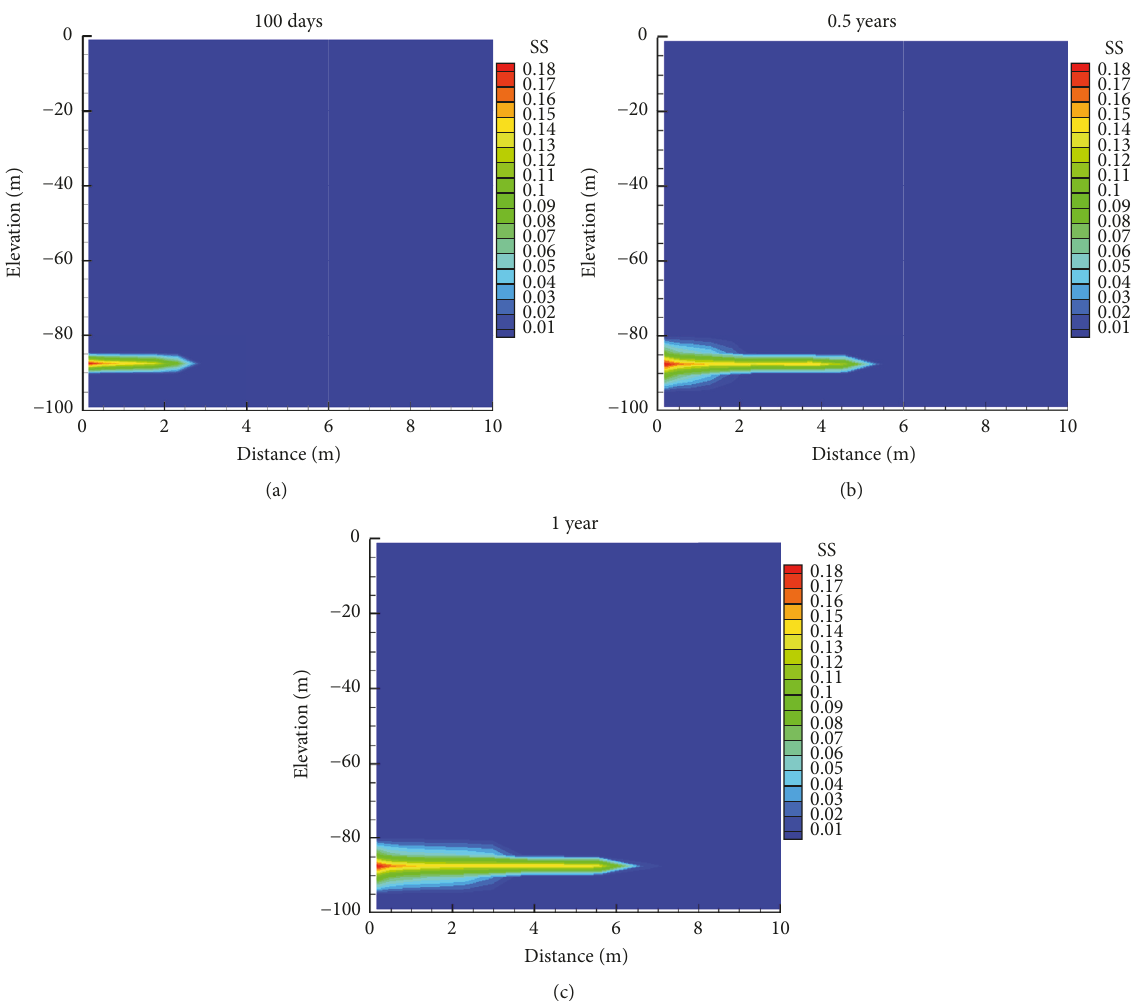
Figure 9: Contour map of solid saturation ( 𝑆 𝑠 ) near the injection well (solid saturation ( 𝑆 𝑠 ) is observed in the range of 0 to 10 m, (a) after 100 days of CO 2 injection, (b) after half a year of CO 2 injection, and (c) after one year of CO 2